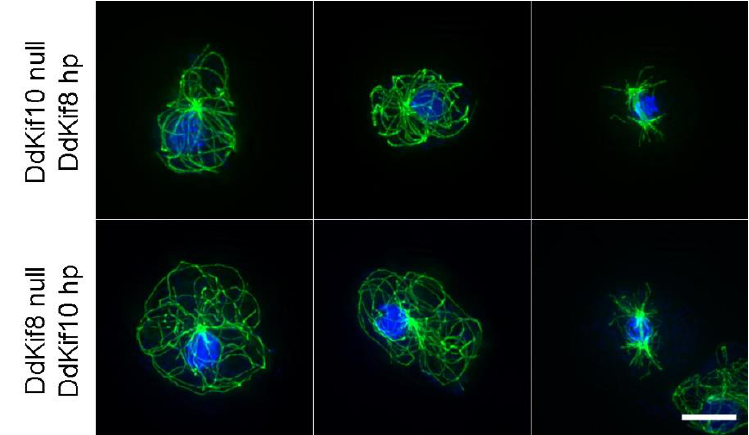
Figure 4. Complementary hairpin analysis. The top row shows MT arrangements (green) in three DdKif8 null cells (two interphase, one mitotic) in the presence of a constitutively expressed Dd Kif10 hairpin construct. The bottom three rows show the same arrangement, but with the null / hairpin constructs reversed. In all cases, the MT arrays look no different than those seen in wild-type cells. Nuclei and chromosomes are shown in blue. Scale bar = 5 μ m.